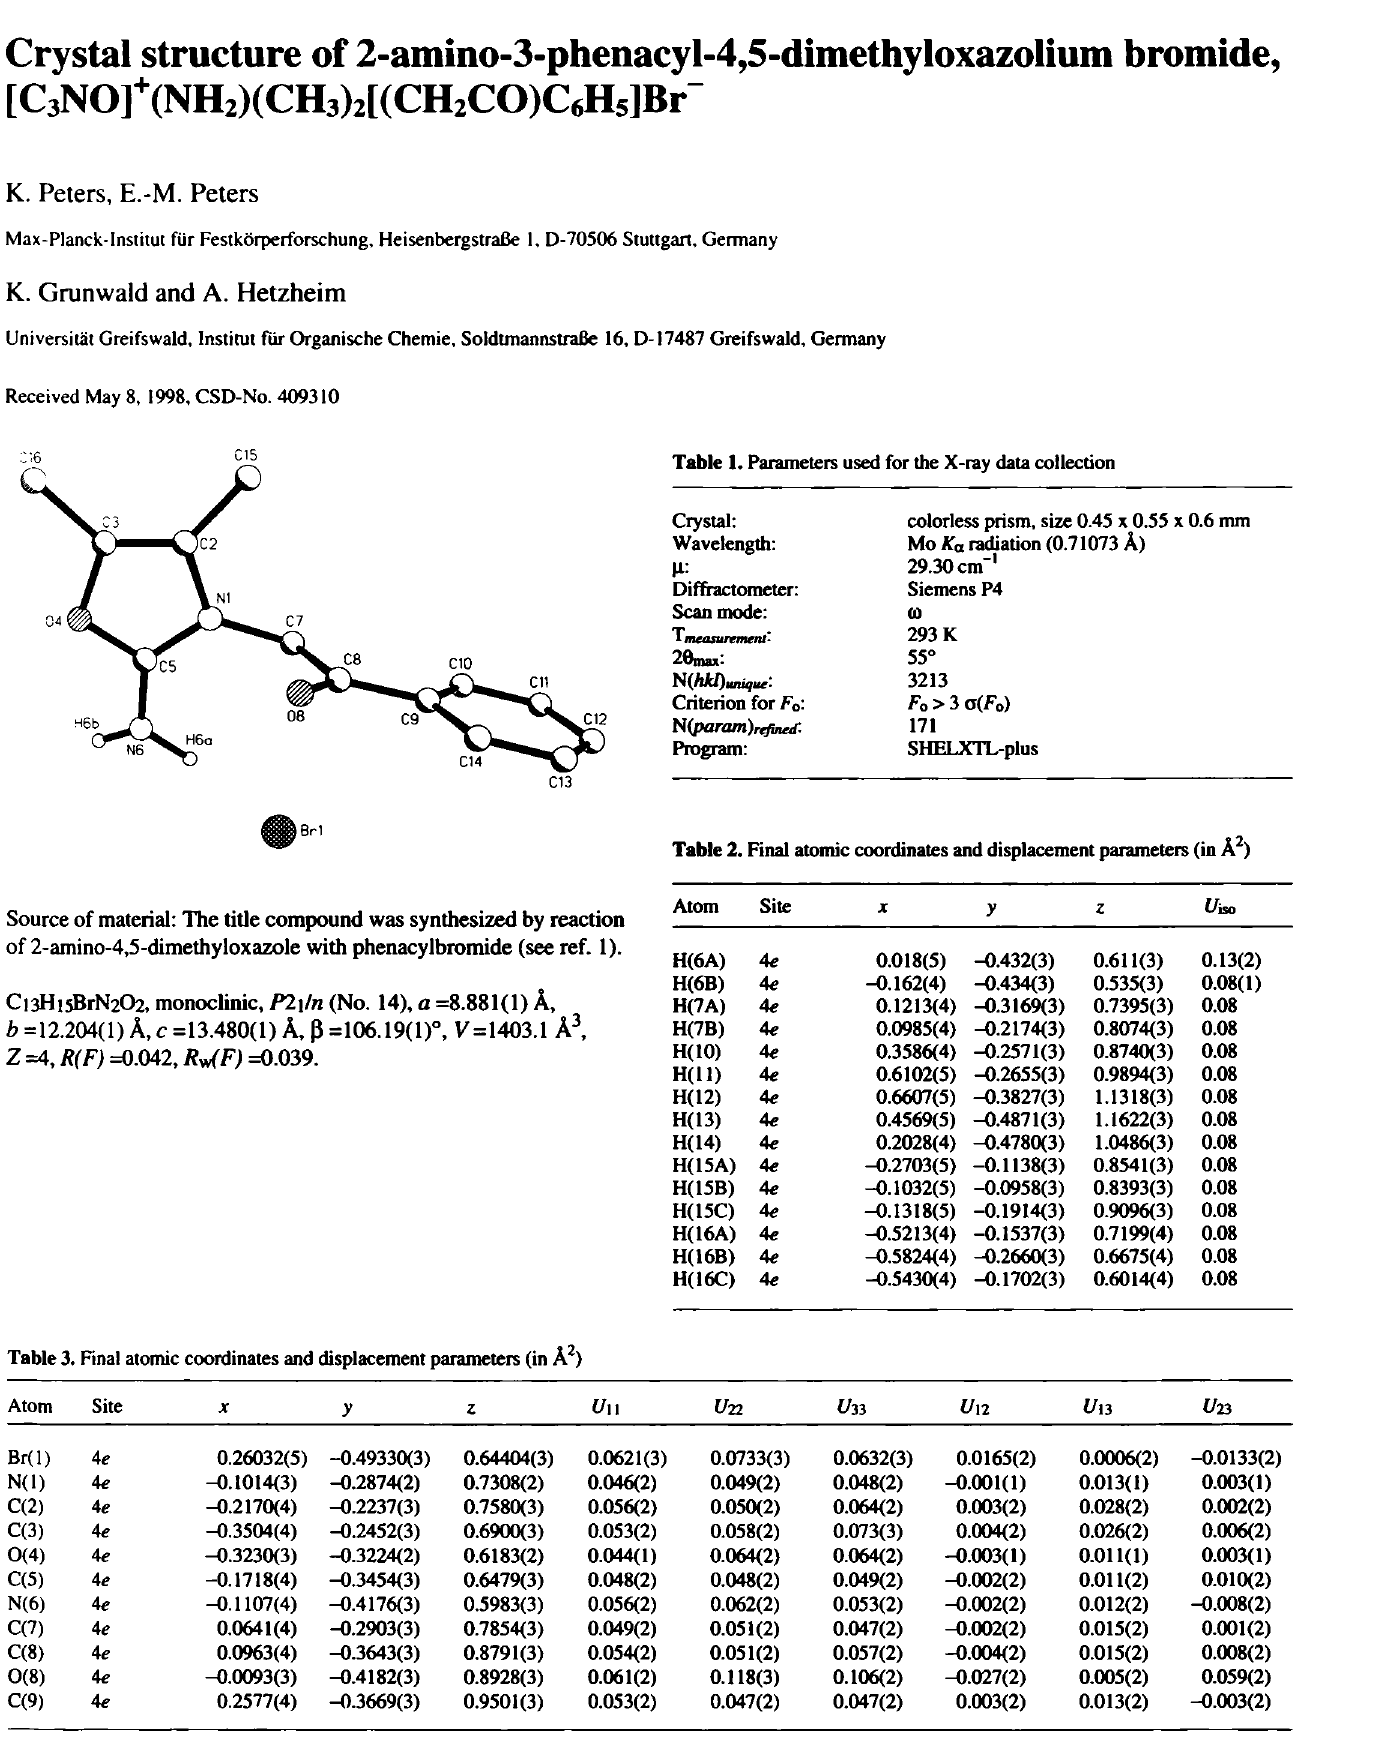
Table 1. Parameters used for the X-ray data collection